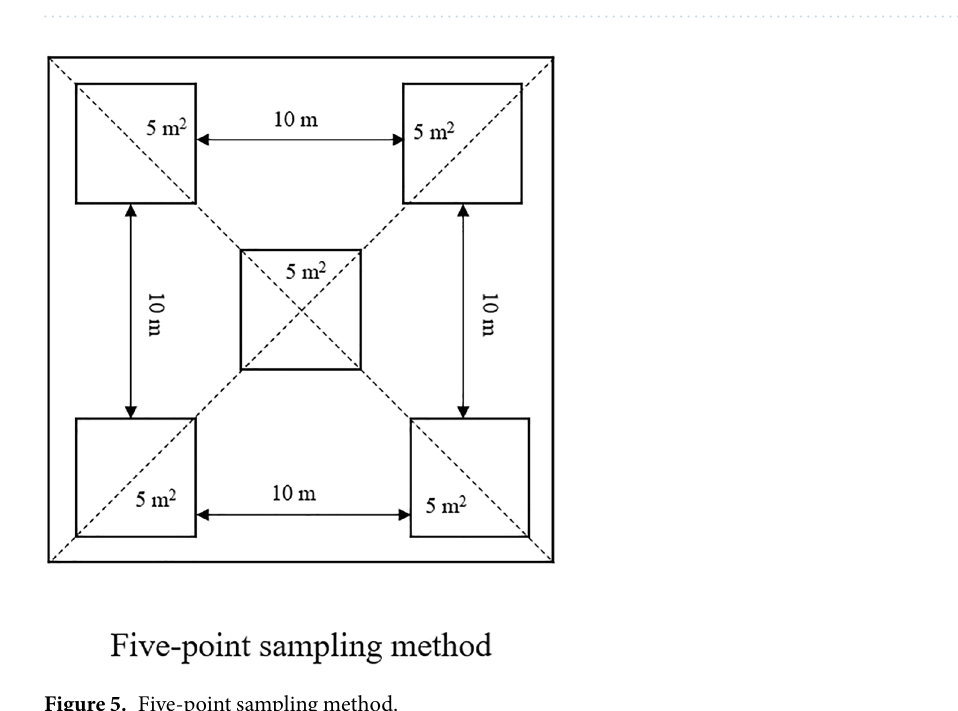
Figure 4. Sampling point information for three consecutive years.